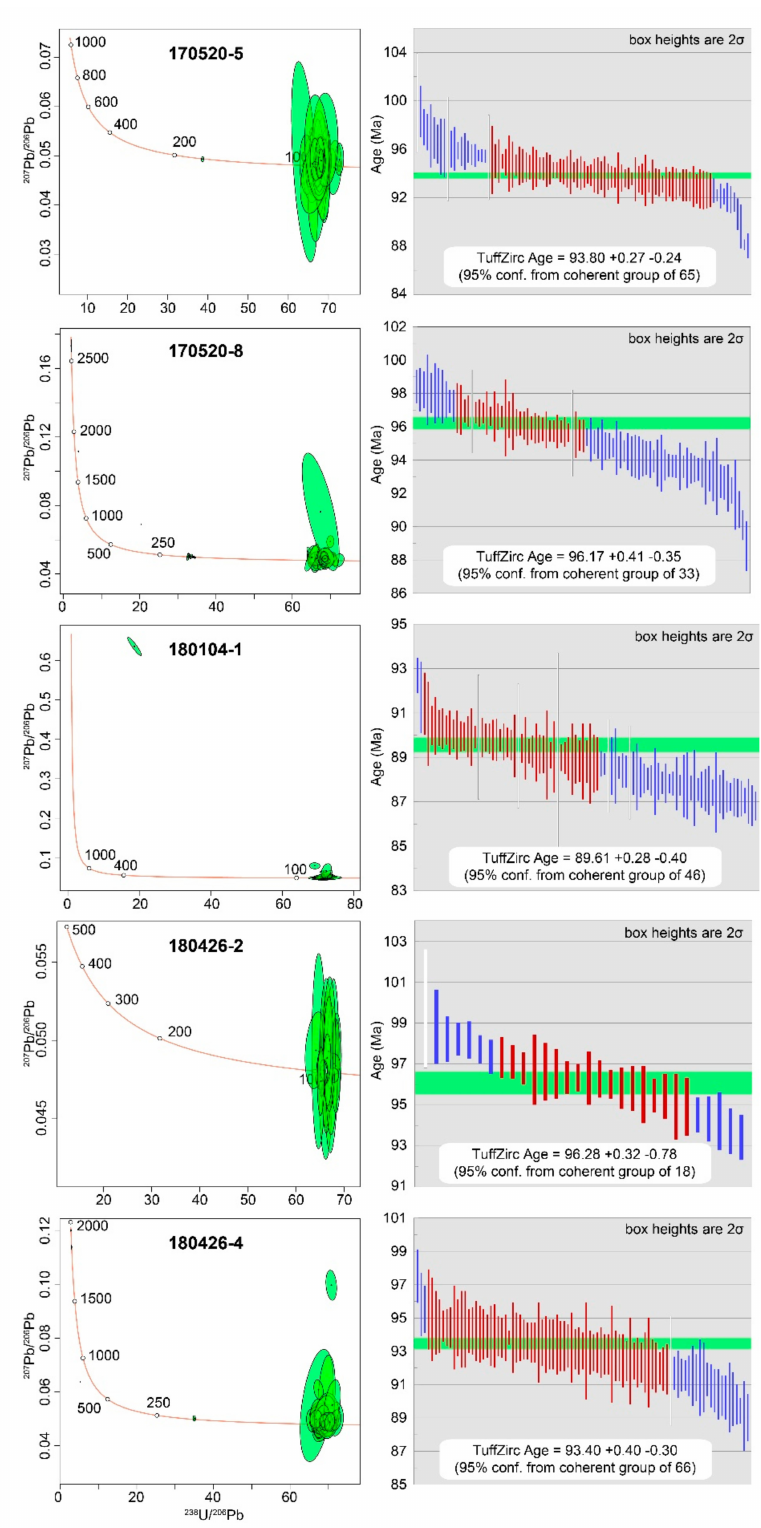
Figure 6. U-Pb Concordia diagrams and weighted mean ages [39] for zircons from tu ff samples of the Neungju Basin. Errors are shown at 2-sigma